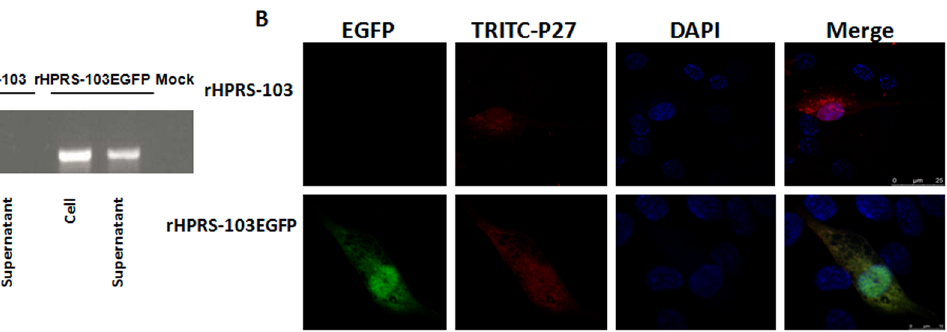
Fig. 1. Generation of infectious ALV-J reporter viruses. A, Detection of recombinant genomes in supernatants and cell lysates of rHPRS-103EGFP- infected DF-1 cells by RT-PCR. RT-PCR was conducted using primers that bind to the EGFP ORF. B, Fluorescence microscopy of rALV-J-EGFP-infected cells. Cells were stained with a monoclonal antibody reactive to the ALV-J p27 protein, and EGFP expression was examined. Cells were fixed at 48 h postinfection and subjected to indirect immunofluorescence to detect p27 protein (red) and EGFP autofluorescence. The position of the nucleus is indicatedby DAPI (blue) staining in the merged